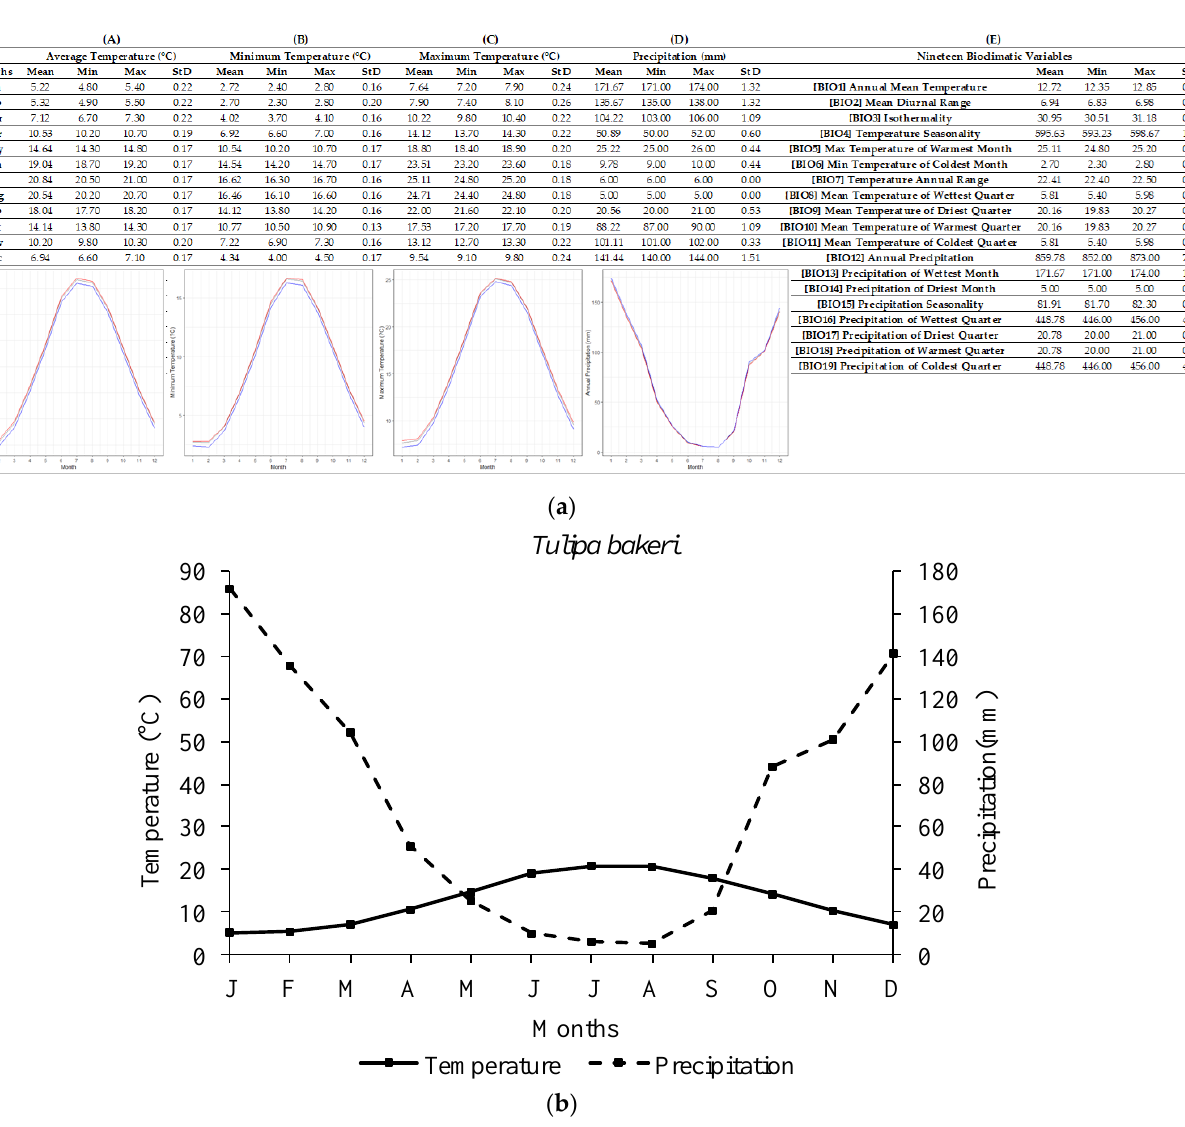
5 of 21 Figure 2. R-derived ecological profile ( a ) and Walter–Lieth climate diagram ( b ) of Tulipa australis based on 55 Greek localities known to date ( n = 55). For ( A – E ), minimum, maximum, and average